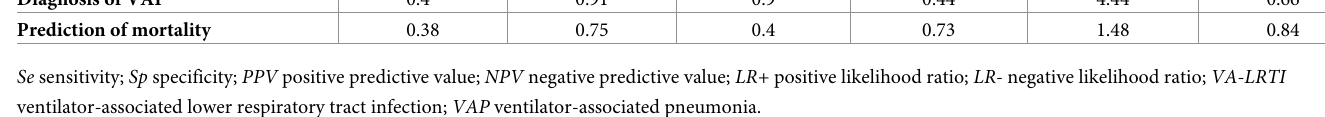
At the time of VA-LRTI diagnosis, patients with VAP had higher total SOFA than those with VAT (mean (SD) 7.4 (4.4) vs 4.7 (4), p < 0.001) (Fig 3). The best performances to differentiate VAT from VAP were observed for a total SOFA � 6. With this cut-off, sensitivity and specific- ity were found at 0.63 and 0.69, respectively (Table 4). At the time of VA-LRTI diagnosis, respiratory SOFA was higher in patients with VAP com- pared to those with VAT (mean (SD) 2.3 (1.2) vs 1.7 (1.1), p = 0.001) (Fig 4). A respiratory SOFA � 3 was associated with the highest Youden index, yielding a sensitivity at 0.49 and a specificity at 0.7 for the diagnosis of VAP (Table 4).